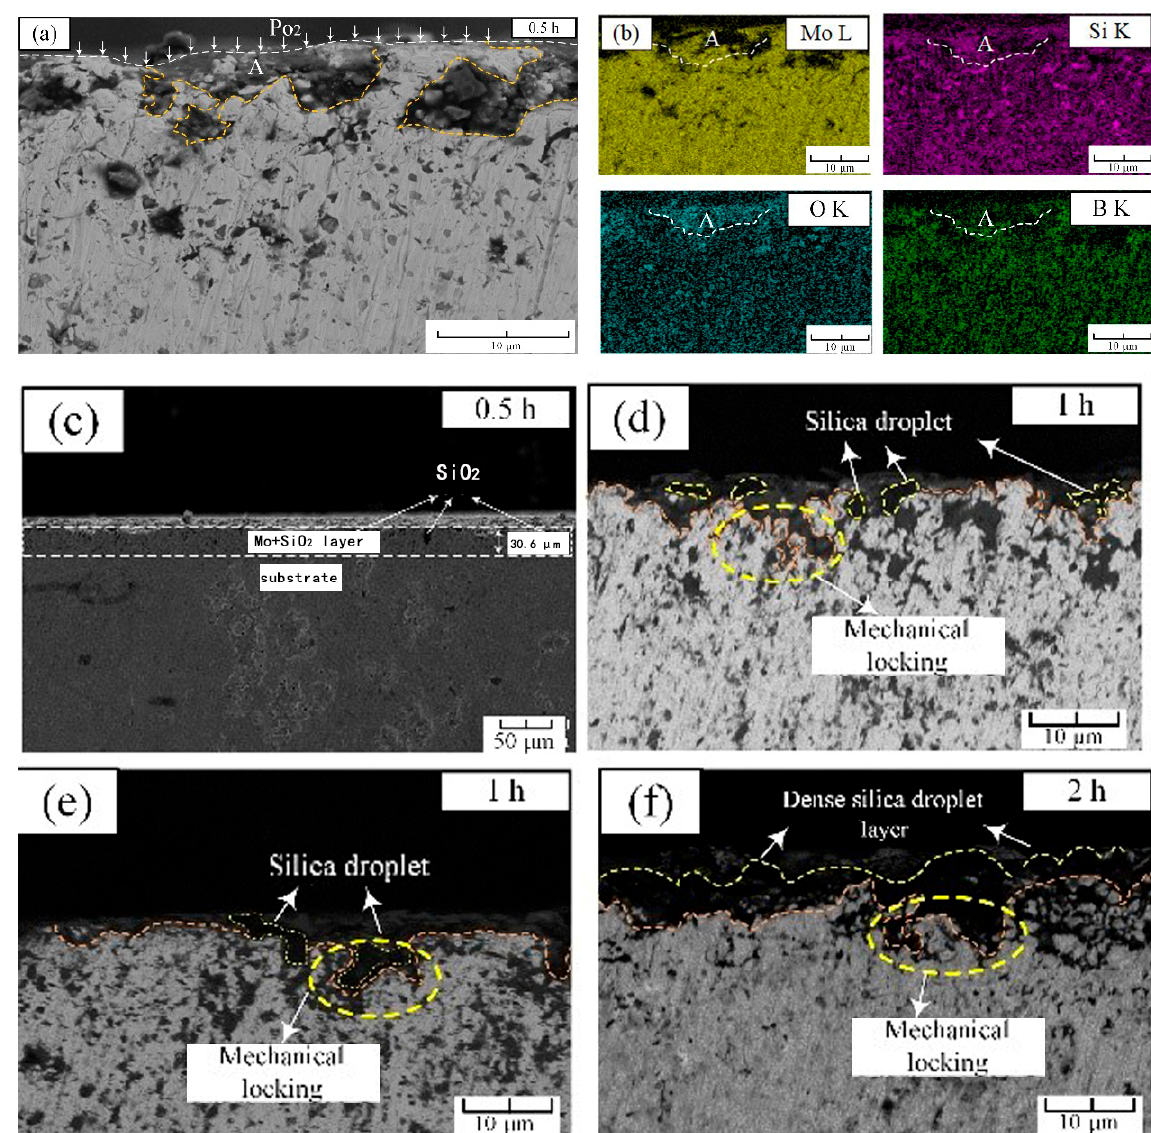
Figure 3. Cross-sectional morphology of pre-oxidized alloy at 1300 ◦ C: ( a ) pre-oxidation for 0.5 h; ( b ) local EDS mappings Figure 3. Cross ‐ sectional morphology of pre ‐ oxidized alloy at 1300 °C: ( a ) pre ‐ oxidation for 0.5 h; ( b ) local EDS mappings in ( a ); ( c ) macro-image of ( a ) for 30 min; ( d , e ) pre-oxidation for 1 h; ( f ) pre-oxidation for 2 in ( a ); ( c ) macro ‐ image of ( a ) for 30 min; ( d , e ) pre ‐ oxidation for 1 h; ( f ) pre ‐ oxidation for 2 h.